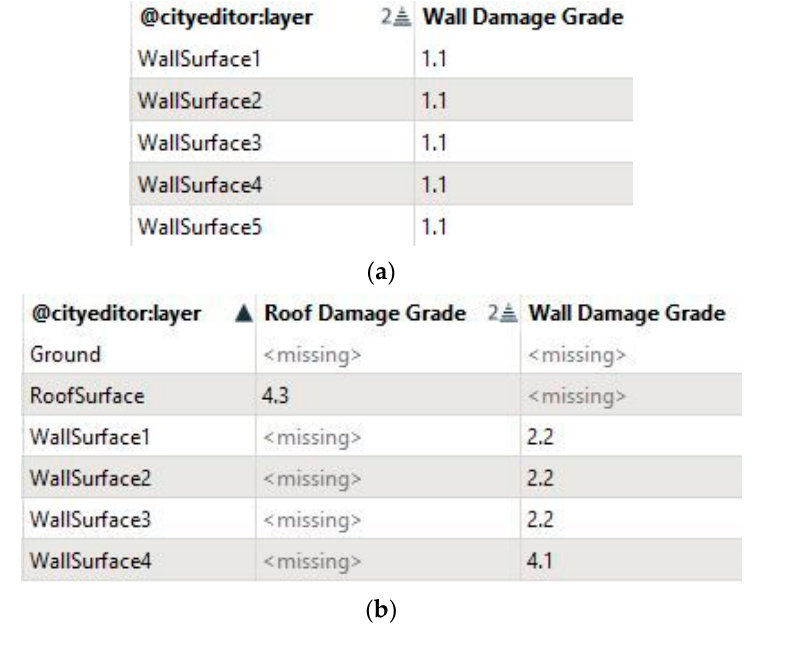
Figure 9 . ( a ) Wall damage grades for building A were 1.1. ( b ) For building B, one wall was characterized with Wall damage 4.1 and the rest with grade 2.2, and the roof was characterized with grade 4.3.